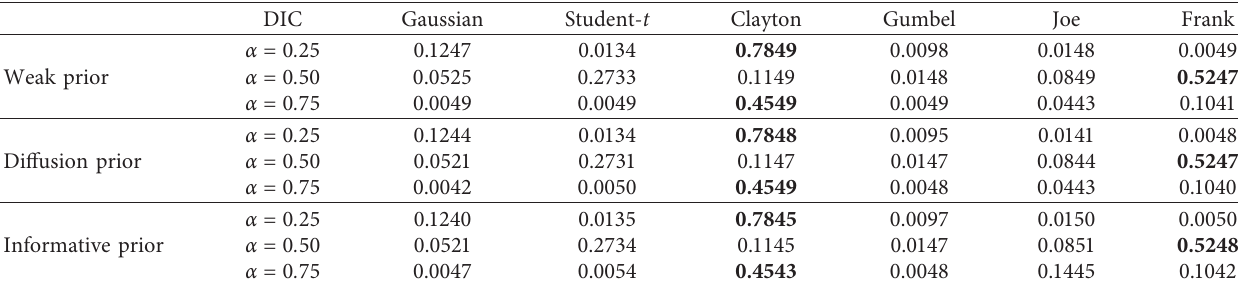
Figure 4: Posterior histograms for copula parameters for the copula-based SUQR model at α � 0 . 5 (left panel), α � 0 . 5 (middle panel), and α � 0 . 5 (right panel). The vertical red line represents the mean parameter estimate. Table 10: Goodness-of-fit test for the copula-based SUQR